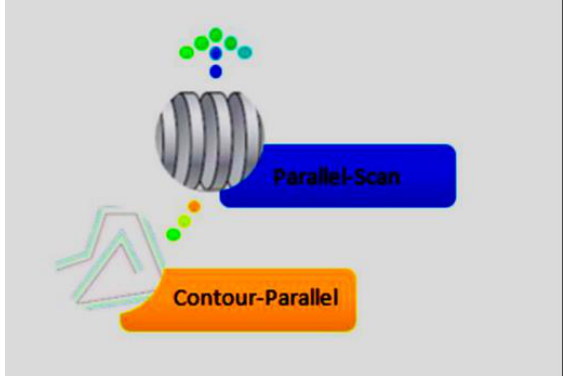
Figure 12. Types of filling paths [44].